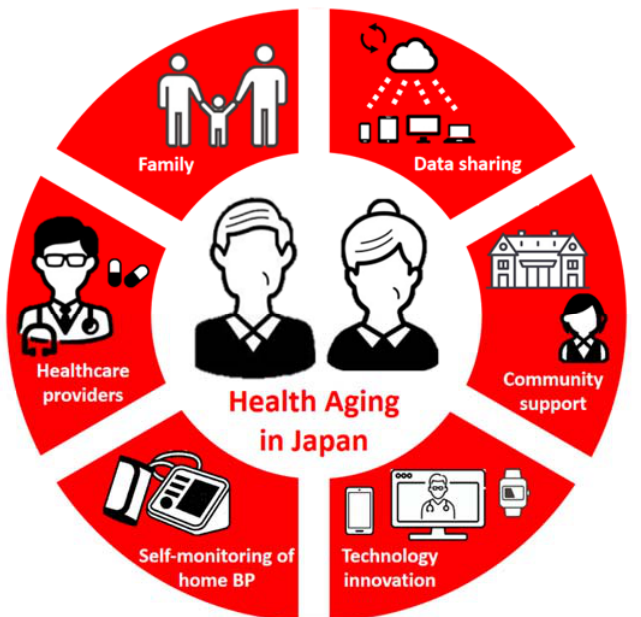
Figure 1. Patient-centered management of hypertension in older people using digital healthcare solutions in Japan.